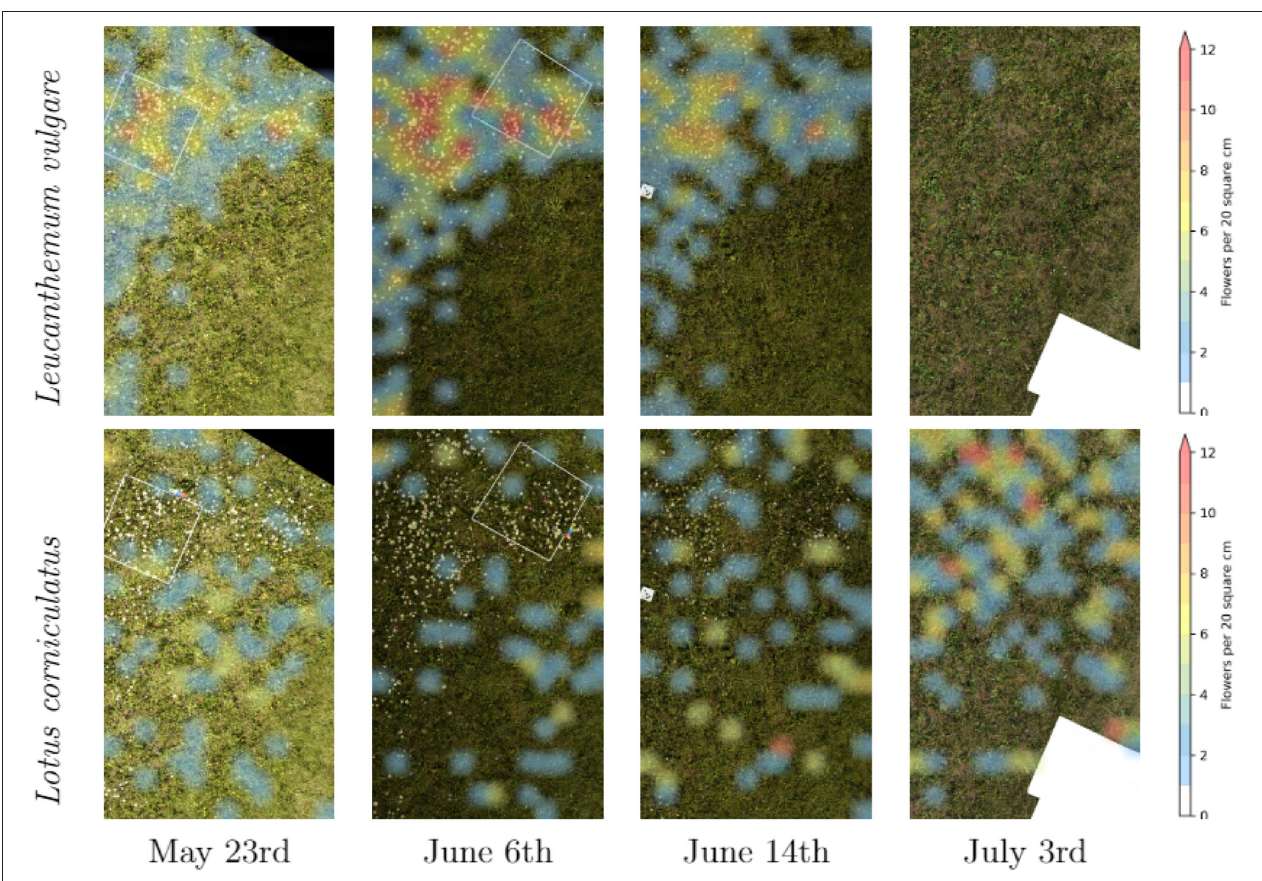
FIGURE 6 | Time series of the distribution of Leucanthemum vulgare and Lotus corniculatus in our main test field.